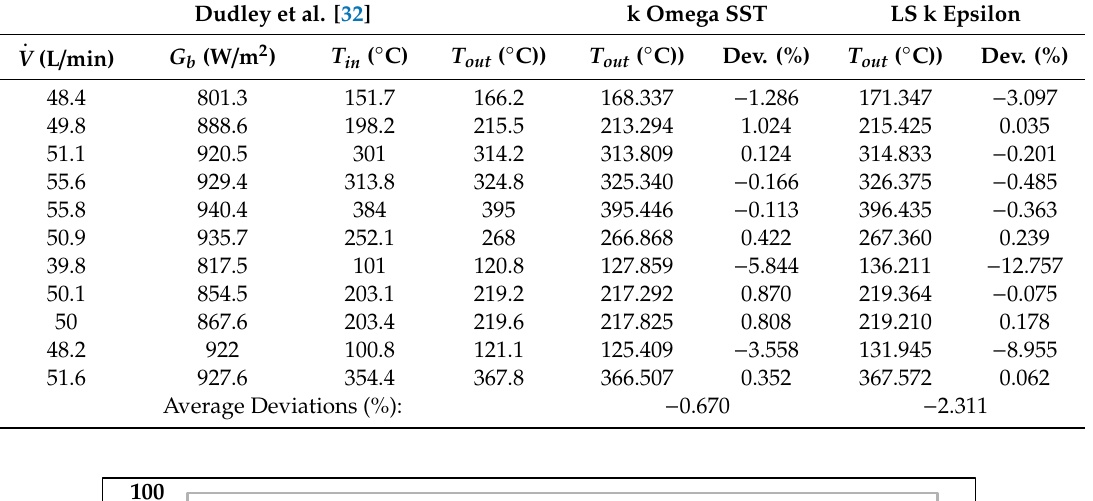
Table 7. A comparison between the experimental data and numerical predictions of the output temperature of working fluid.